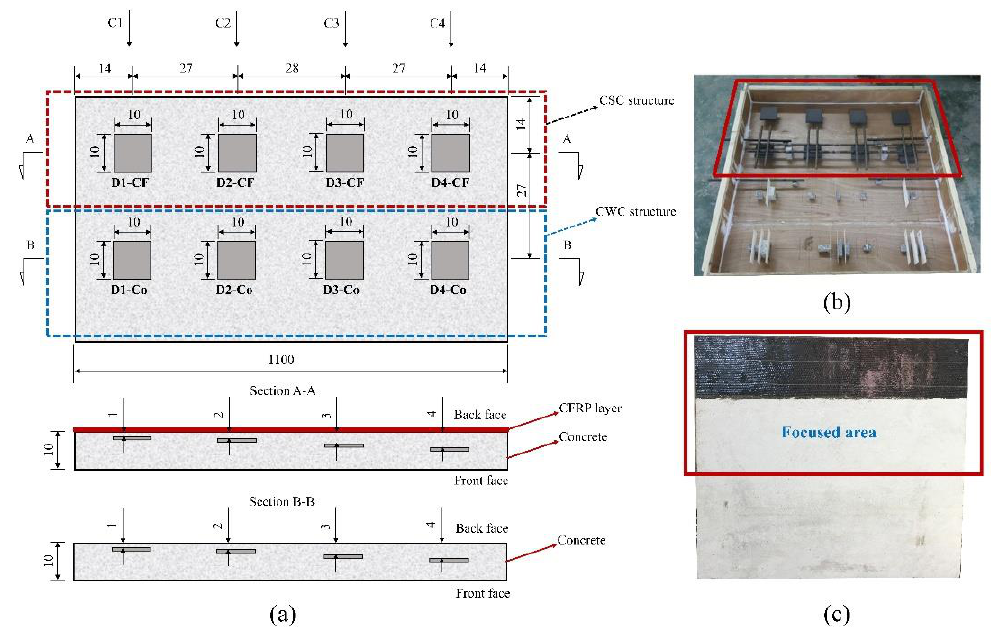
Figure 2. Specimen of concrete strengthened with CFRP (CSC) and concrete without CFRP (CWC): ( a ) arrangement of embedded delaminations; ( b ) formwork of specimen; ( c ) CFRP sheet installed on the back-face of specimen.